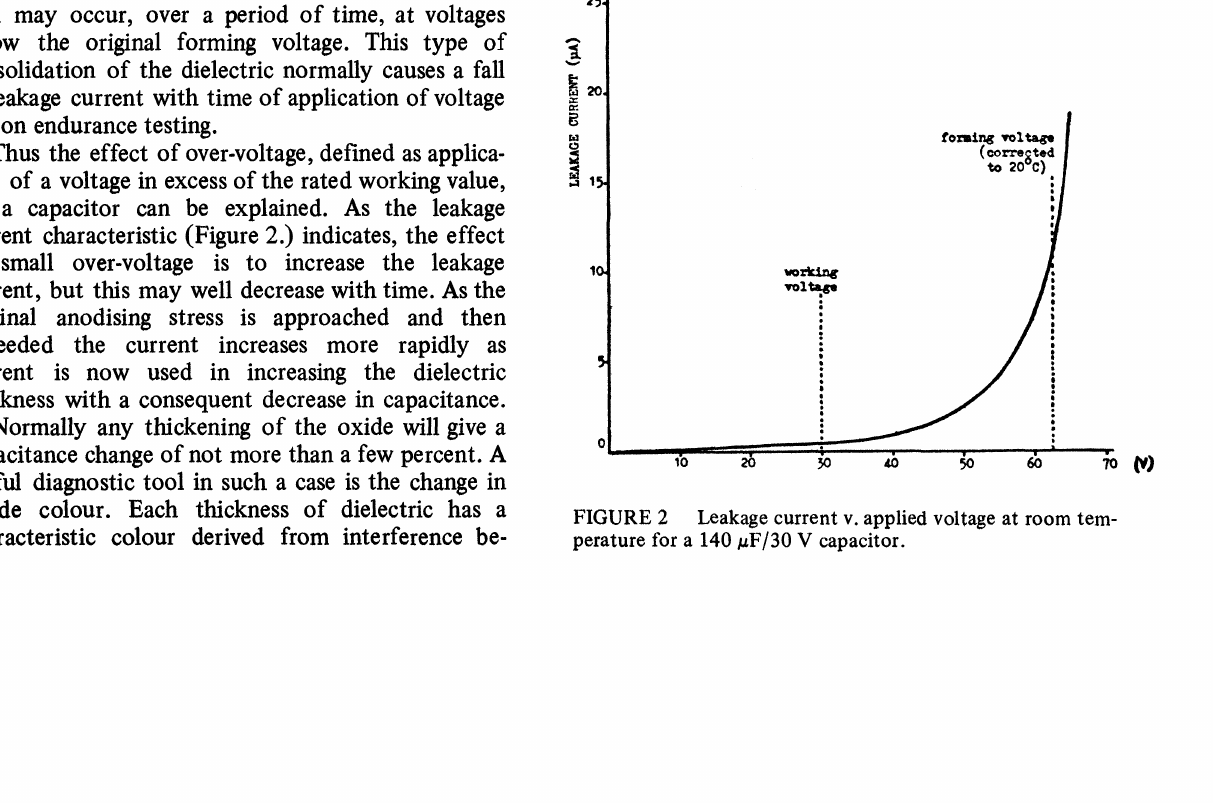
Leakage current v. applied voltage at room tem- perature for a 140 #F/30 V